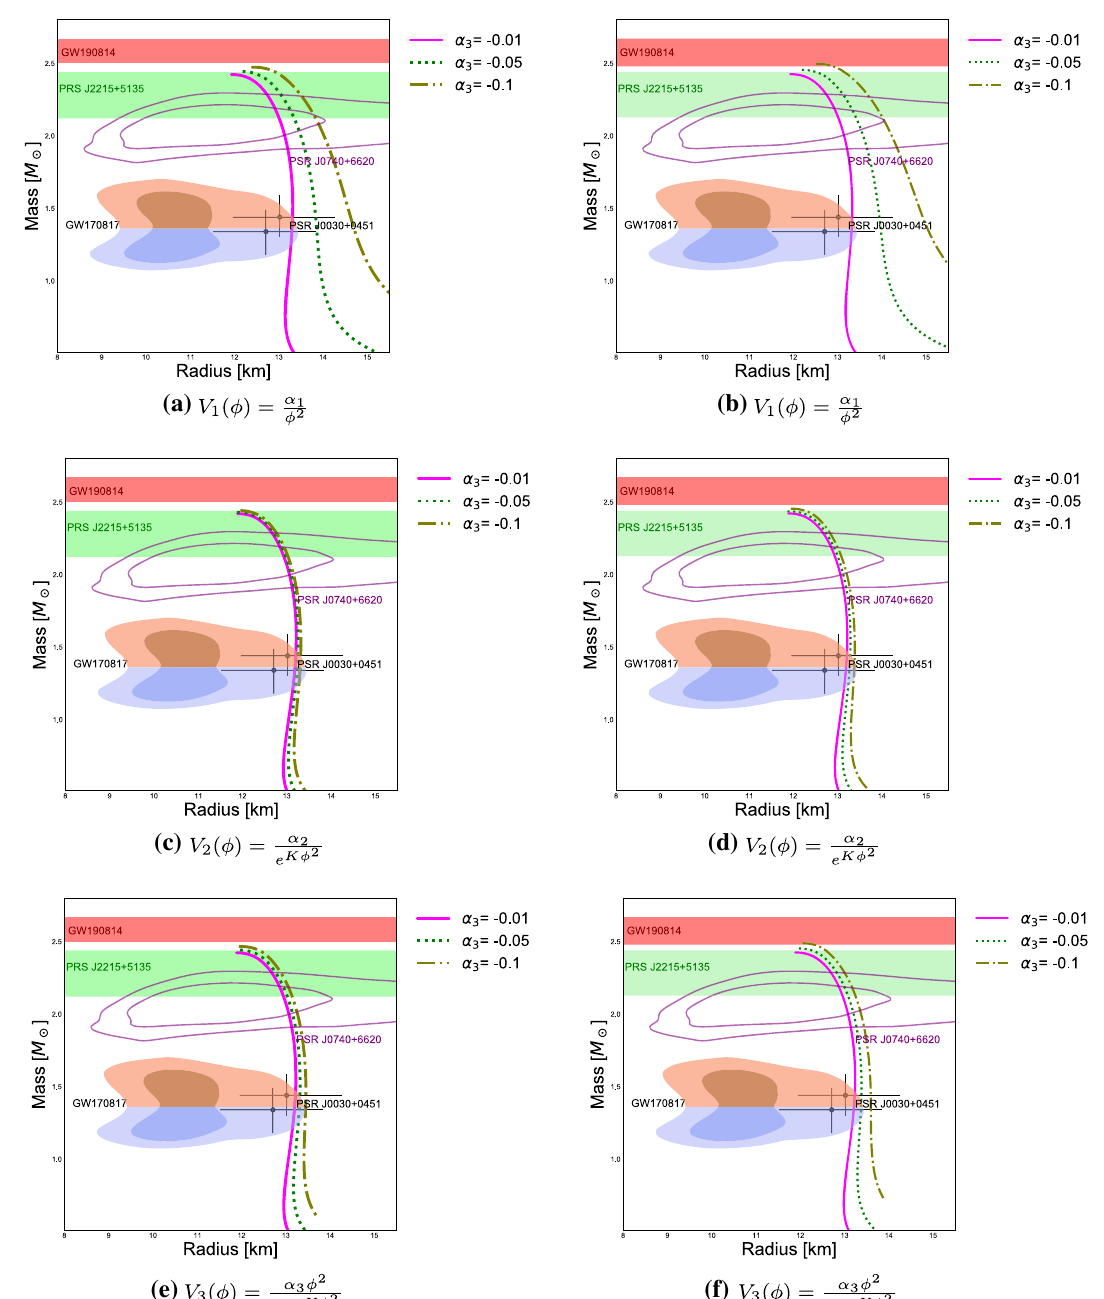
Fig. 6 The mass–radius relation of neutron stars in mimetic gravity for DD2 EoS. φ( 0 ) = 1: left panels and φ( 0 ) = 0 . 8: right panels and K = 0 . 5